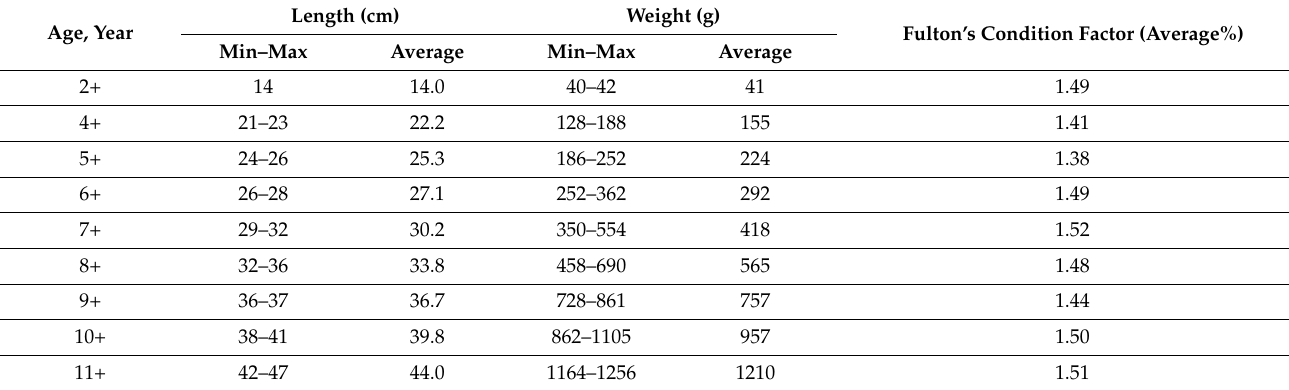
Table 4. Biological characteristics and age composition of the Balkhash marinka from Tokyrauyn River.